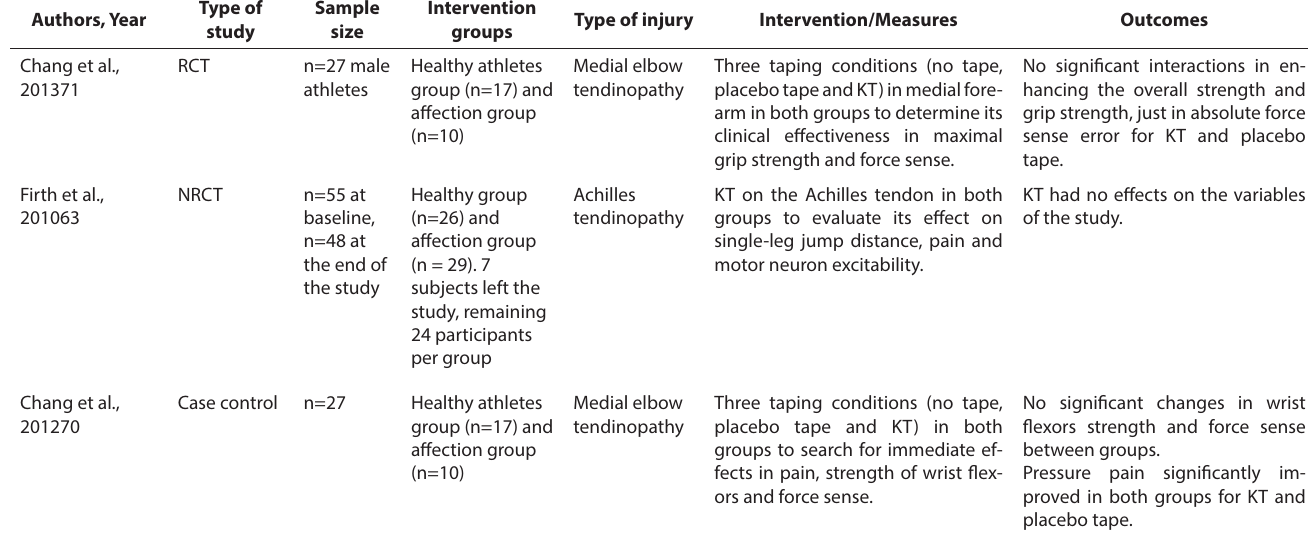
TABLE 2. Characteristics of selected studies